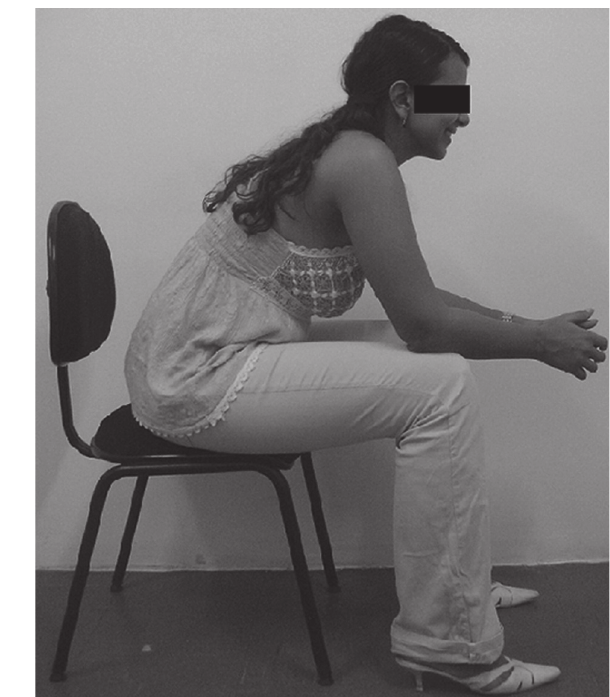
Figura 2 - Simulação da postura sentada com o tronco in- clinado a 45º Fonte: Dados da